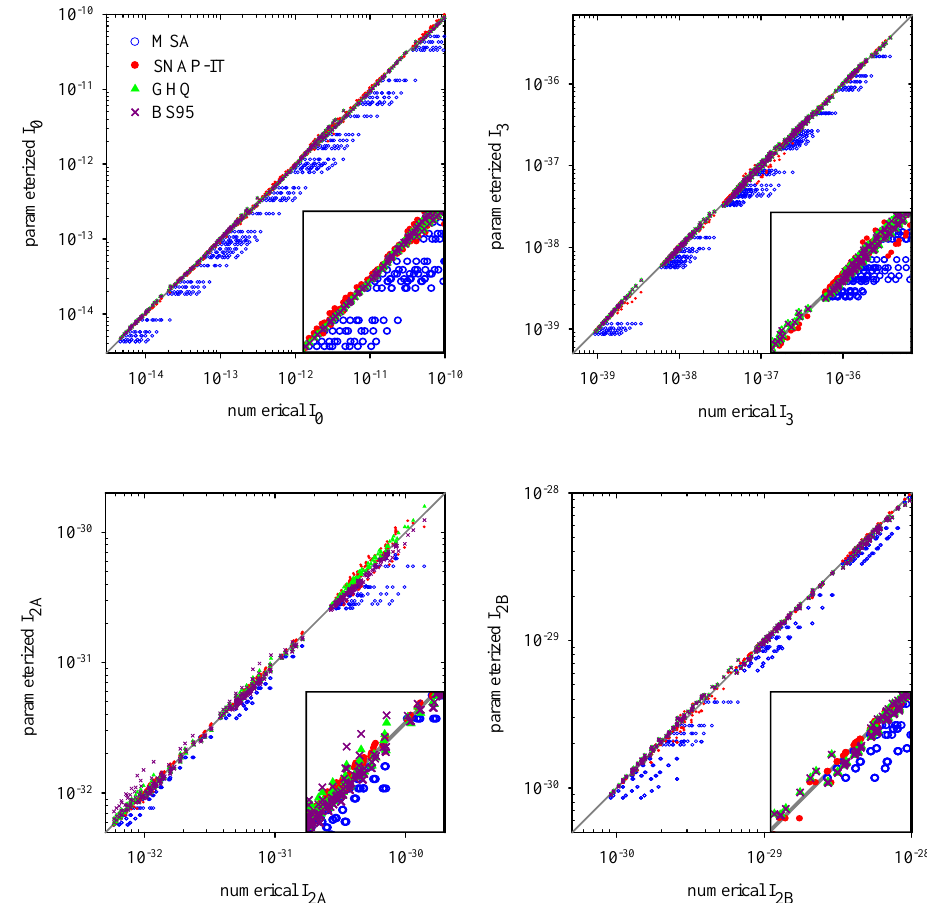
Figure 8: Same as Figure 6, but for inter-modal coagulation. Upper left: (cid:1835) Fig. 8. Same as Fig. 7, but for intermodal coagulation. Upper left: I 0 ,B ; upper right: I 3 ,A or − I 3 ,B ; lower left: I 2 ,A ; and lower right: I 2 ,B ; Lower left: (cid:1835) ; Lower right: (cid:1835) . (cid:3398)(cid:1835) (cid:2871),(cid:3003) (cid:2870),(cid:3002) (cid:2870),(cid:3003)